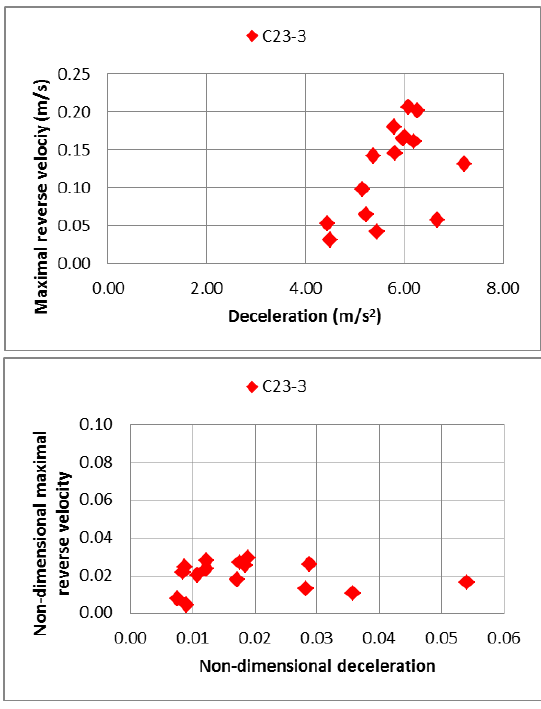
Fig. 19. Dynamic properties – reverse velocity dependence on system deceleration An anomaly was detected at the C23 valve during the dynamic measurements at 2 kg load. Based on that, the C23 valve was re-tested in dynamic way.